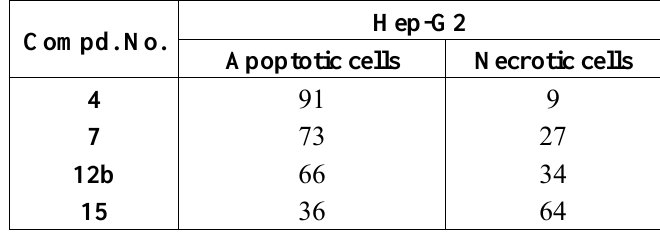
Table 2. Apoptosis and necrosis assay for cytotoxic compounds only. Compd. No.